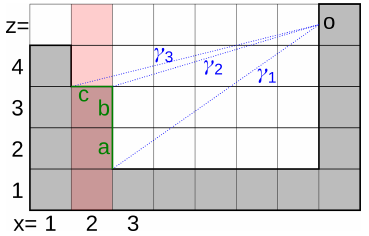
Figure 5. Obstacle identification algorithm (vertical cross